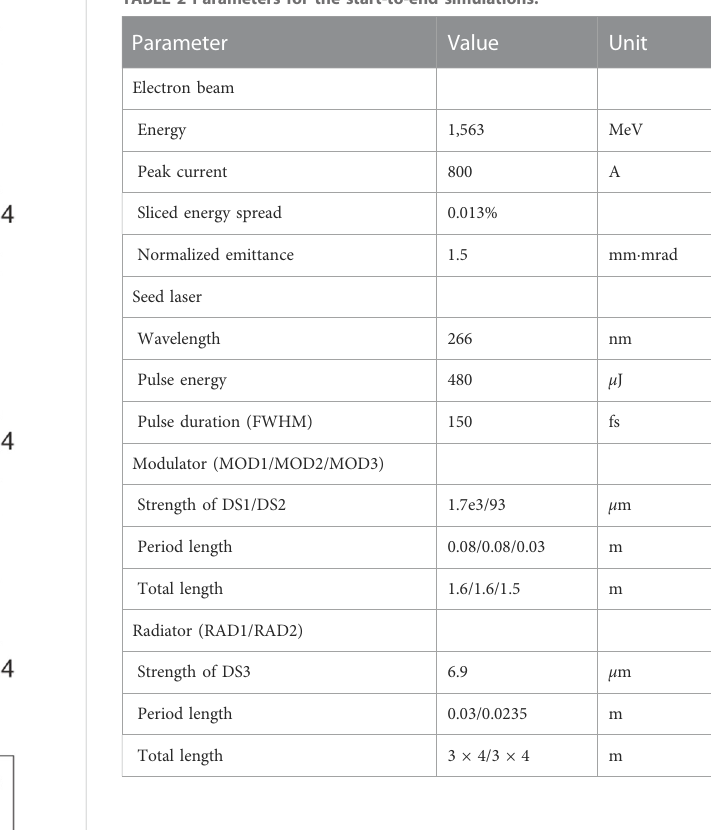
TABLE 2 Parameters for the start-to-end